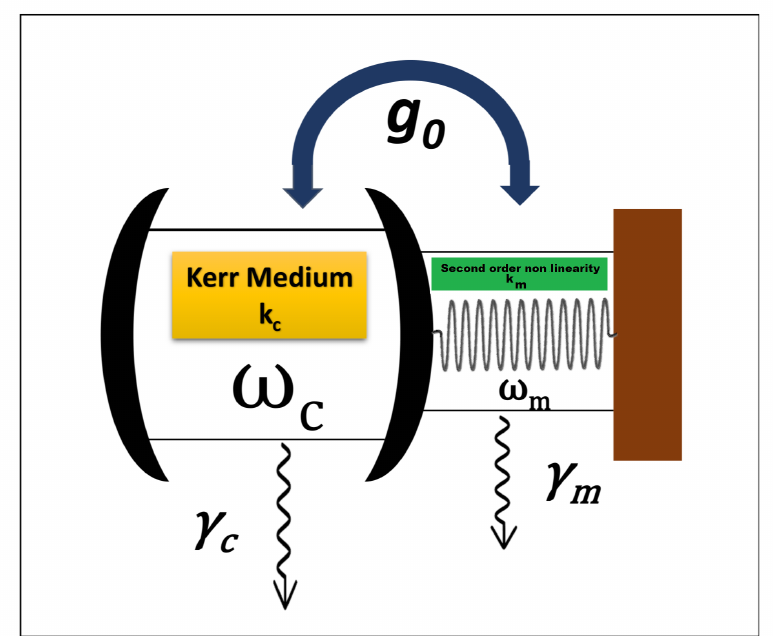
Figure 1. Schematic diagram of optomechanical system taken as quantum memory model. An optical mode (with frequency ω c ) couples with the mechanical mode (with frequency ω m ) via the radiation– pressure coupling g 0 . Additionally, Kerr nonlinearity of strength k c and quadratic nonlinearity of strength k m are included in optical and mechanical modes, respectively. Here, γ c is the optical decay rate and γ m is the mechanical damping rate of the respective